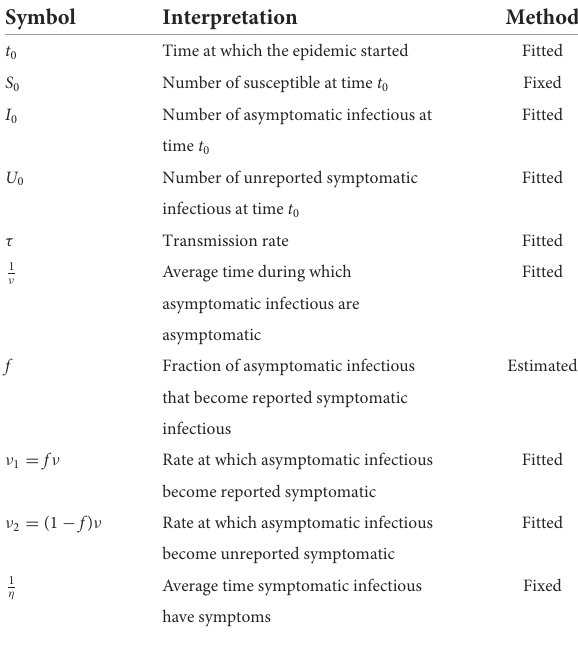
Table A1 Parameters and initial conditions of the model